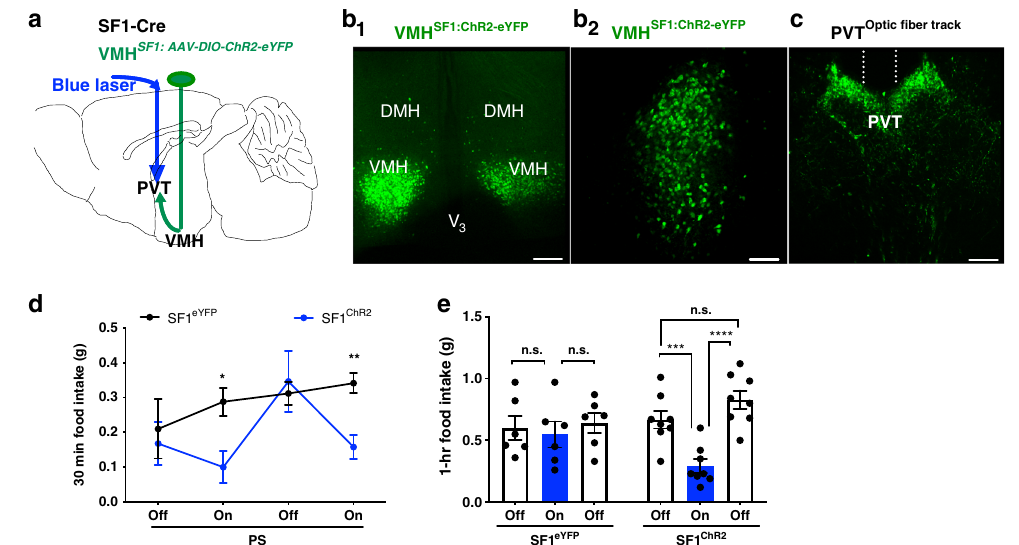
Fig. 2 PS of VMH SF1 projections to the PVT inhibits food intake. a Schematic illustration of viral transduction of VMH SF1 neurons with ChR2-eYFP in SF1-Cre mice and an optic fi ber above PVT for PS. b , c Representative images of b 1 , b 2 ChR2-eYFP-transduced SF1 neurons in VMH and c ChR2-positive SF1 projections in the PVT and the optic fi ber track above PVT. d , e PS of ChR2-expressing SF1 projections in the PVT signi fi cantly reduced food intake in ChR2- transduced mice ( n = 4 males and 4 females) but not in control eYFP-transduced mice ( n = 3 males and 3 females): d Group data of food intake collected from fed mice in the LLP at the intervals of 30 min with blue laser off and on respectively (eYFP vs ChR2 1ston , p = 0.0121; eYFP vs ChR2 2ndOn , p = 0.0021); e group data of refeeding collected from 24 h food-deprived mice in the ELP at the intervals of 1 h before, during and after blue laser on (eYFP 1st off vs On , p = 0.7117; eYFP On vs 2nd off , p = 0.4985; ChR2 1st off vs On , p = 0.001; ChR2 On vs 2nd off , p < 0.0001). Two-tailed Student ’ s t -test; data represent mean ± s.e. m.; * p < 0.05; ** p < 0.01; *** p < 0.001; **** p < 0.0001. Scale bars, 200 μ m for b 1 , 100 μ m for b 2 and c . DMH dorsomedial hypothalamus, PVT